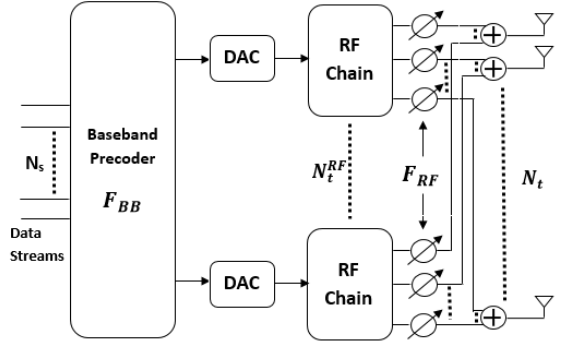
Fig. 3. Hybrid Beamforming Here X is the input data matrix having N s columns, each representing a data stream. F is a precoding matrix with dimensions N s × N t . H is the mmWave channel matrix. The matrix n , having N r columns representing the receiver noise at each antenna element. The received signal is fur- ther processed and recovered through combining